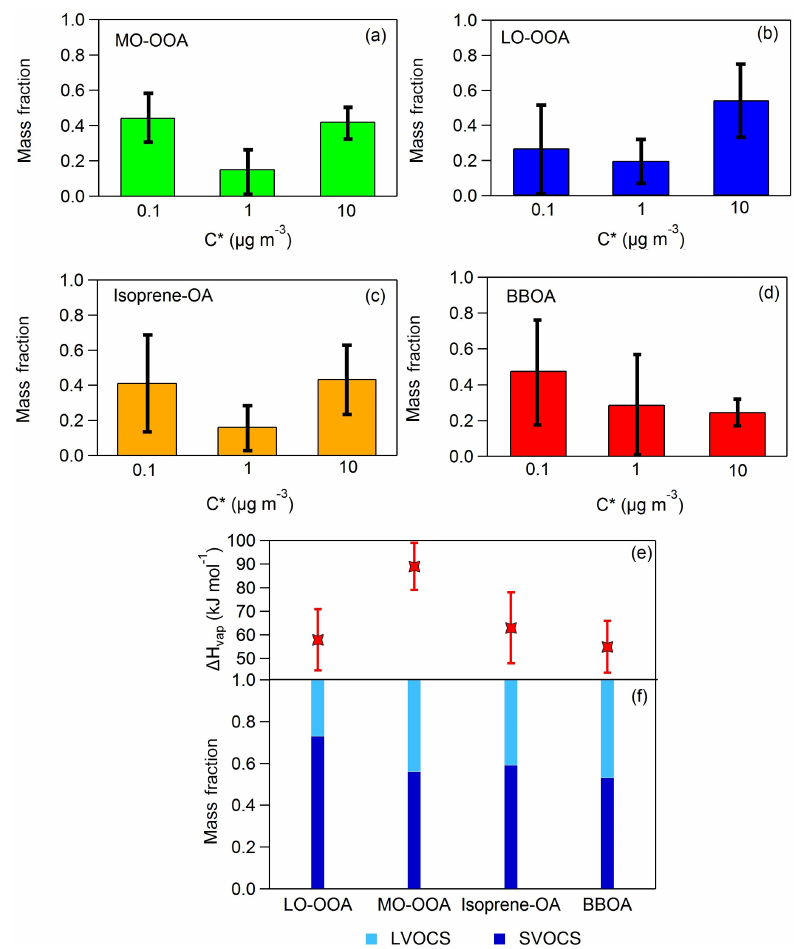
Figure 3. (a–d) Predicted volatility distributions of the OA PMF factors. The error bars correspond to the uncertainties derived using the approach of Karnezi et al. (2014), (e) vaporization enthalpies comparison between the four OA factors and (f) volatility compositions comparison between the four OA